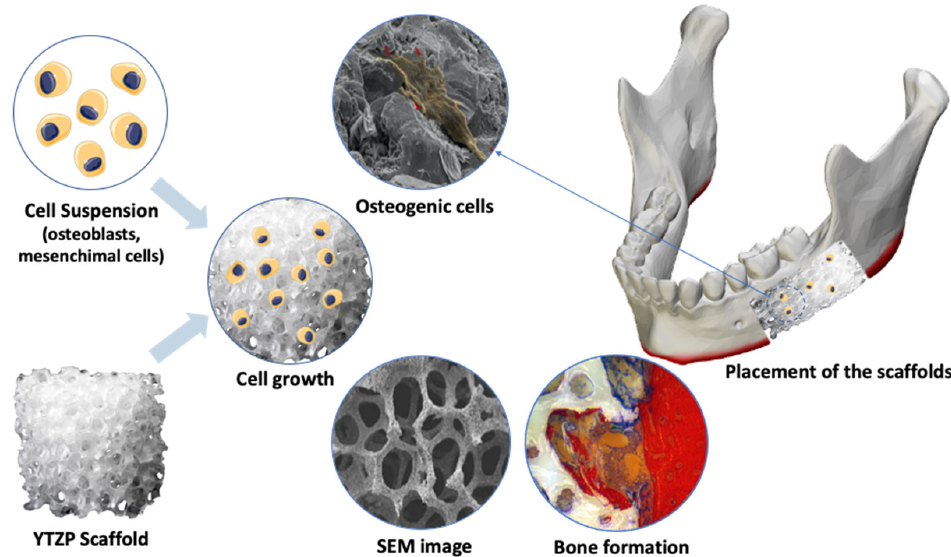
Figure 3. Schematics of the cell growth in the porous zirconia structures.